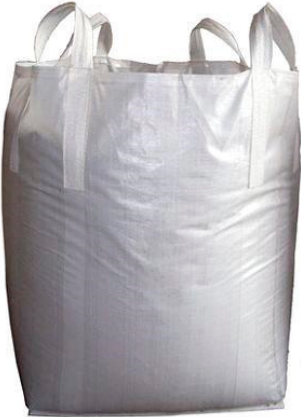
Figure 1. Post-consumer polypropylene woven bags.